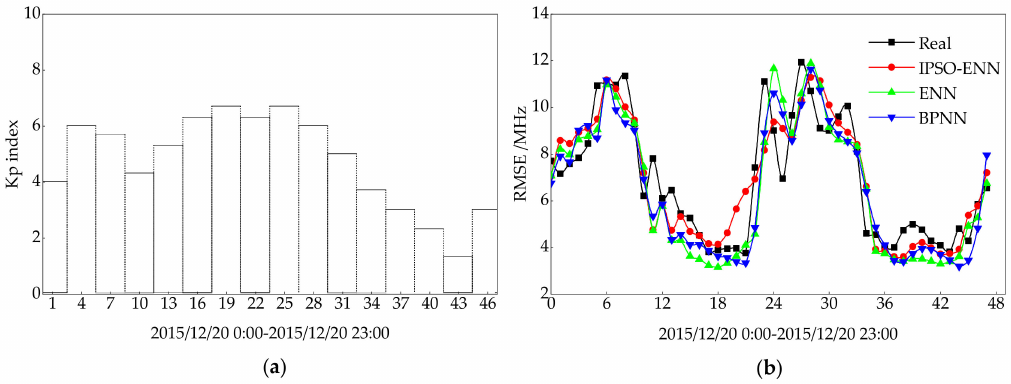
Figure 7. Data during ionosphere disturbances. ( a ) Change of Kp index during ionosphere disturbances; ( b ) observed and predicted values during ionosphere